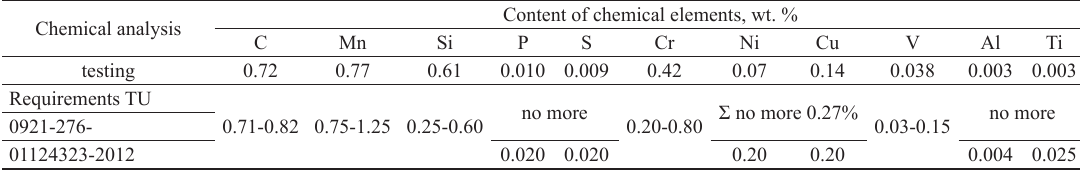
Table 1. Chemical composition of DT350 category rails.